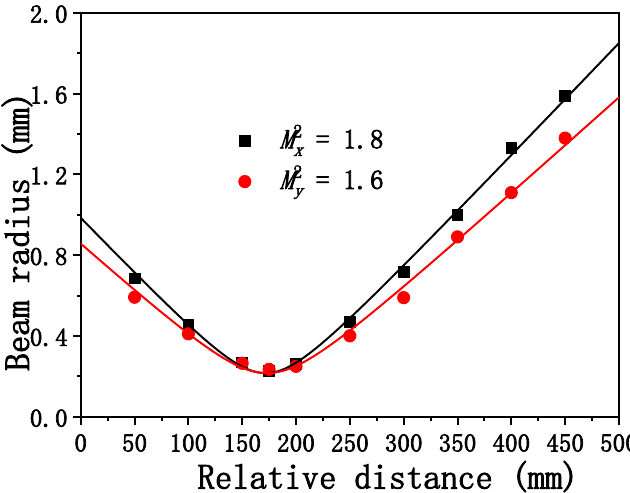
Figure 5. Beam quality of the Ho:YVO 4 laser.